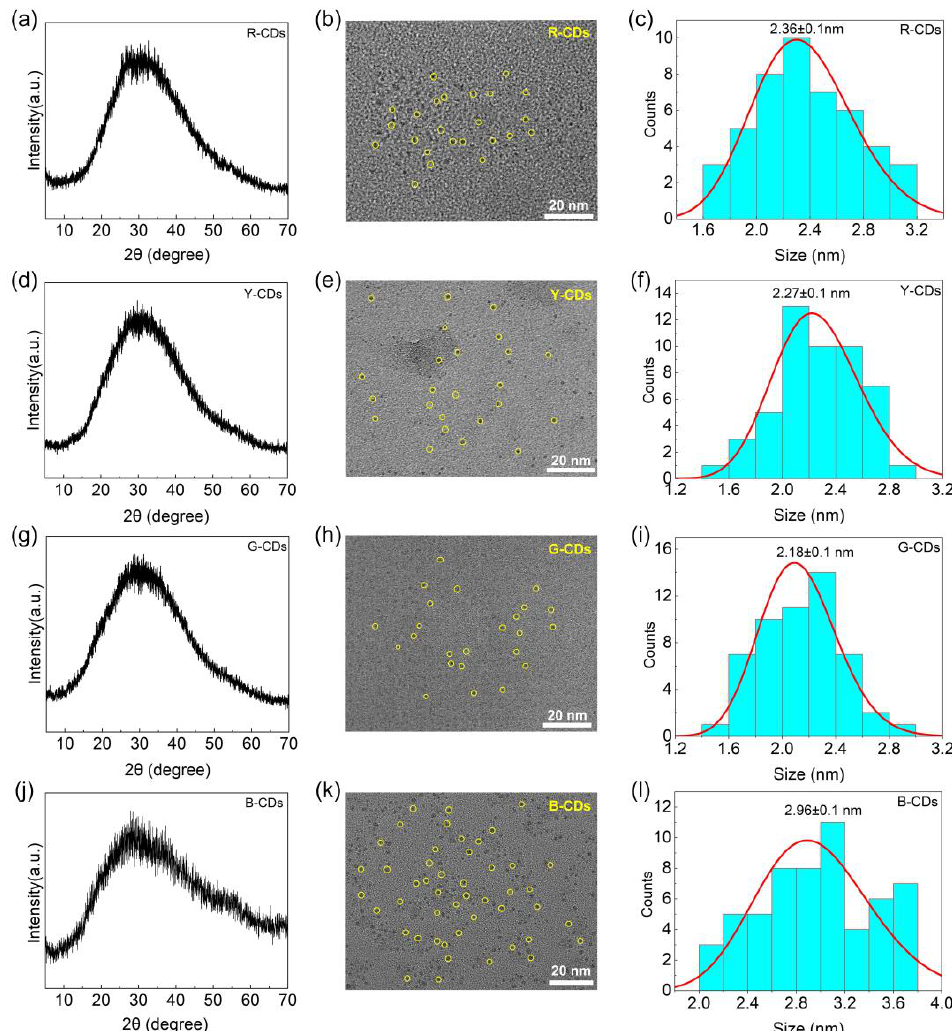
Figure 3. XRD patterns of R-CDs ( a ), Y-CDs ( d ), G-CDs ( g ), and B-CDs ( j ). TEM images of R-CDs ( b ), Y-CDs ( e ), G-CDs ( h ), and B-CDs ( k ); the scale bar is 20 nm. Size distributions of R-CDs ( c ), Y-CDs ( f ), G-CDs ( i ) and B-CDs ( l ).